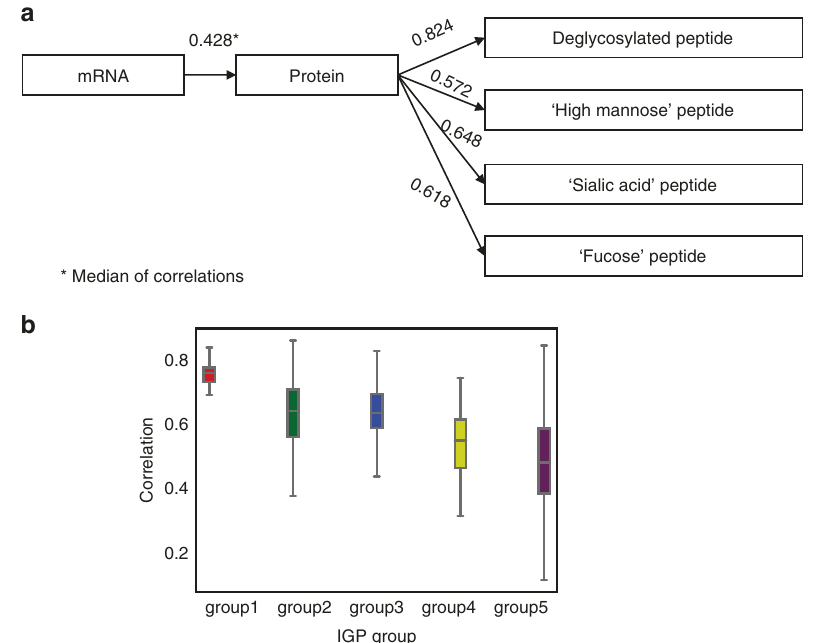
Fig. 5 Correlation analysis between mRNA, proteins, and intact glycopeptides. a Correlation analysis following the central dogma. b Correlation analysis between proteins and intact glycopeptides in fi ve subgroups of intact glycopeptides with different glycans. In group 1, n = 26 glycopeptides; In group 2, n = 79 glycopeptides; In group 3, n = 85 glycopeptides; In group 4, n = 43 glycopeptides; In group 5, n = 95 glycopeptides. For b , the box outlines denote the IQR, the solid line in the box denotes median correlation value, and the whiskers outside of the box extend to the minimum and maximum correlation values. Source data are provided as a Source data fi